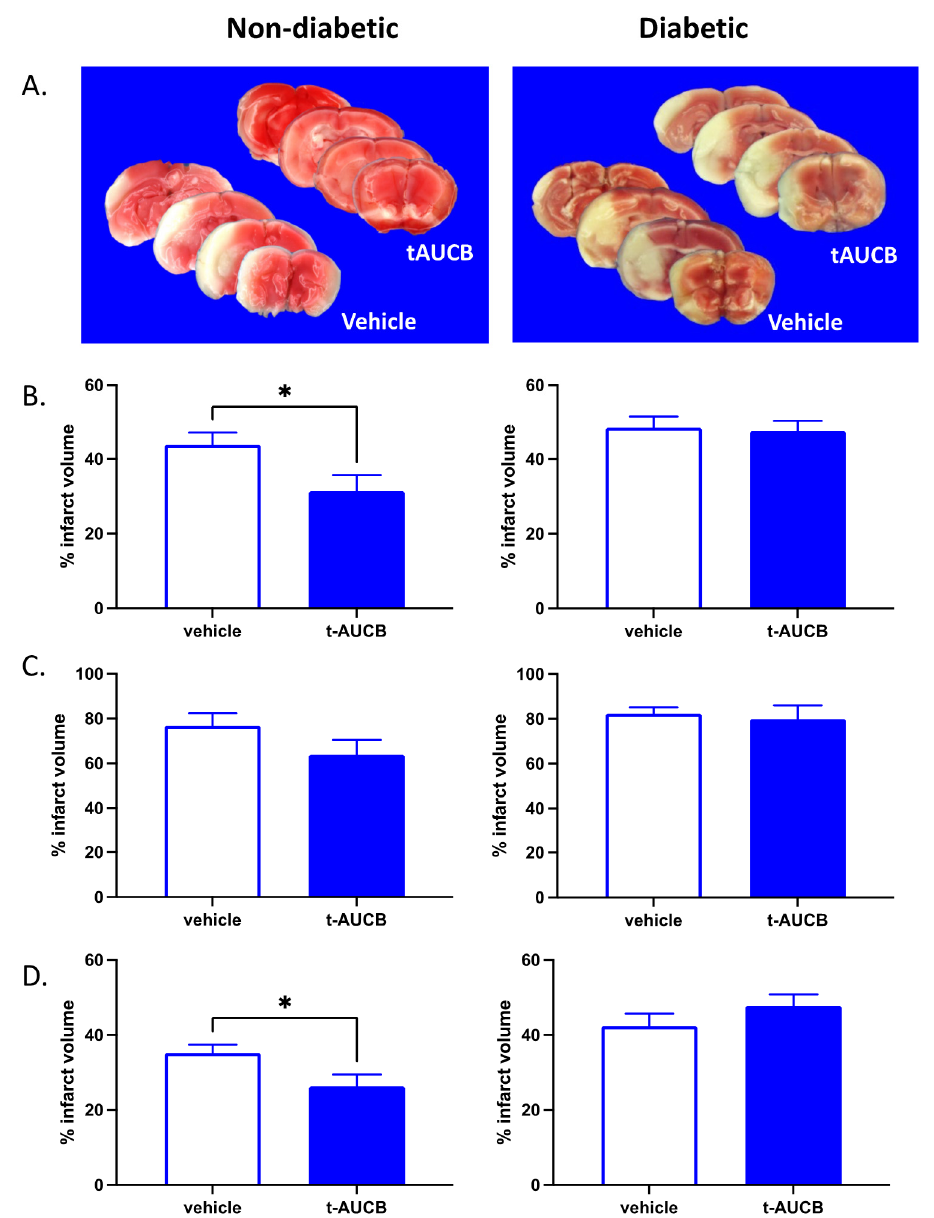
Figure 2. tAUCB administered during vessel occlusion reduces infarct volume in non-diabetic, but not in diabetic mice. tAUCB, 2 mg/kg, was administered i.p. 30 min into 1 h MCA occlusion, infarct was assessed by TTC 24 h later. ( A ) Representative TTC images of coronal sections from non-diabetic ( left ) and diabetic ( right ) mouse brains. Infarct volume in ( B ) cortex, ( C ) caudate putamen, and ( D ) hemisphere of non-diabetic ( left ) and diabetic ( right ) mice, n = 7–8, * p < 0.05.